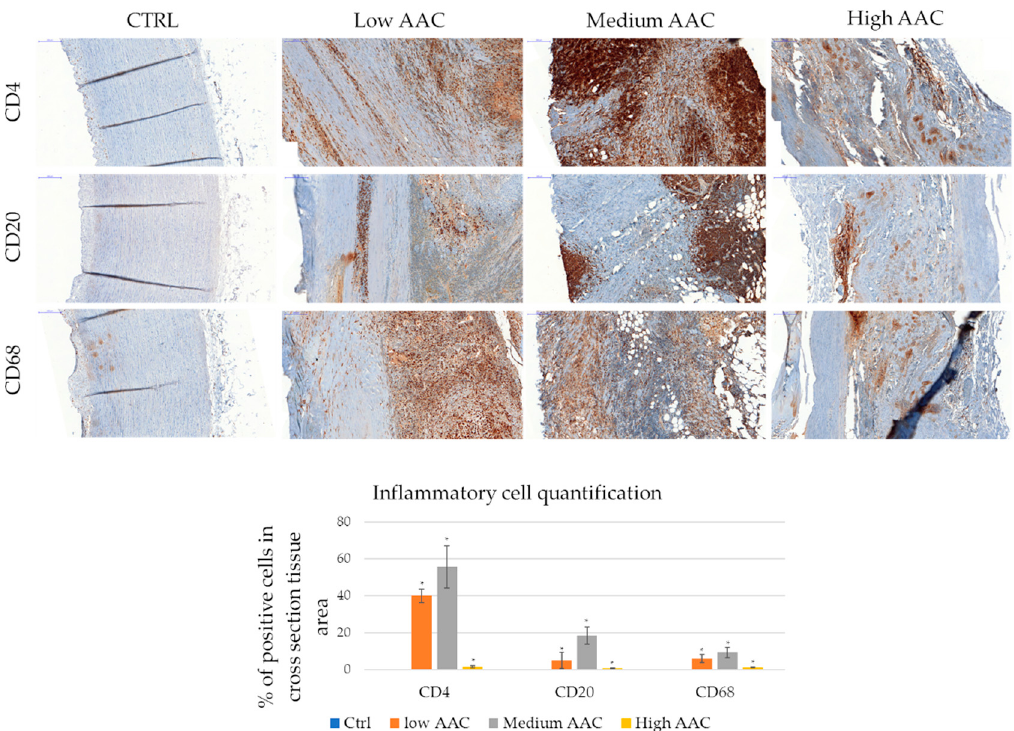
Figure 2. Inflammatory cell infiltration in AAA. Representative immunohistochemistry for anti-Cluster of differentiation 4 (CD4), CD8, CD68 staining. CD4+ is performed for T-helper lymphocytes, CD8+ for T-killer, and CD68+ for monocytes-macrophage. Healthy aorta, represented on the left, is negative for inflammatory cells infiltration. Scale bar 200 µm. Inflammatory cell quantification is represented as a percentage of positive cell covered area. * indicates p ≤ 0.05 respect to controls (healthy tissues).